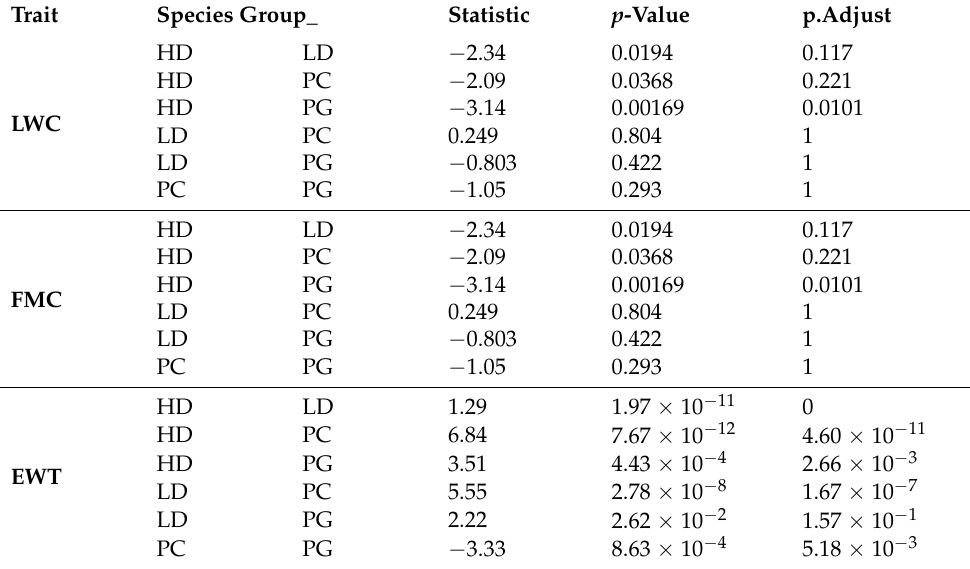
Table 3. Dunn’s post hoc test adjusted using the Bonferroni method for the three leaf traits. Water con- tent: LWC (%) = liquid water content; FMC (%) = fuel moisture content; EWT (g cm − 2 ) = equivalent water thickness for 24 subsamples collected from each species invasive (PG = Psidium guajava an HD= Hovenia dulcis) and native (PC= Psidium cattleianum and LD= Luehea divaricata ). Trait Species Group_ p -Value